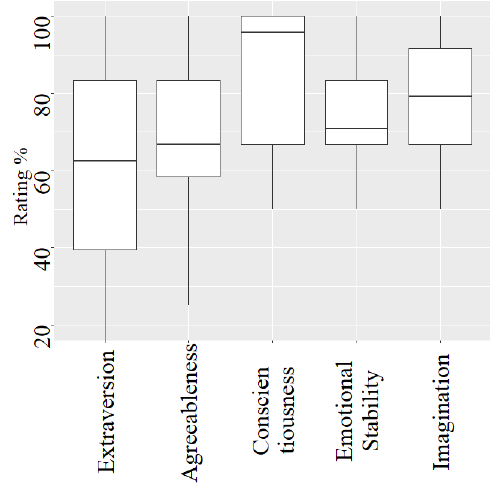
Figure 2 : Partici pants’ personality Table 1. Personality of the